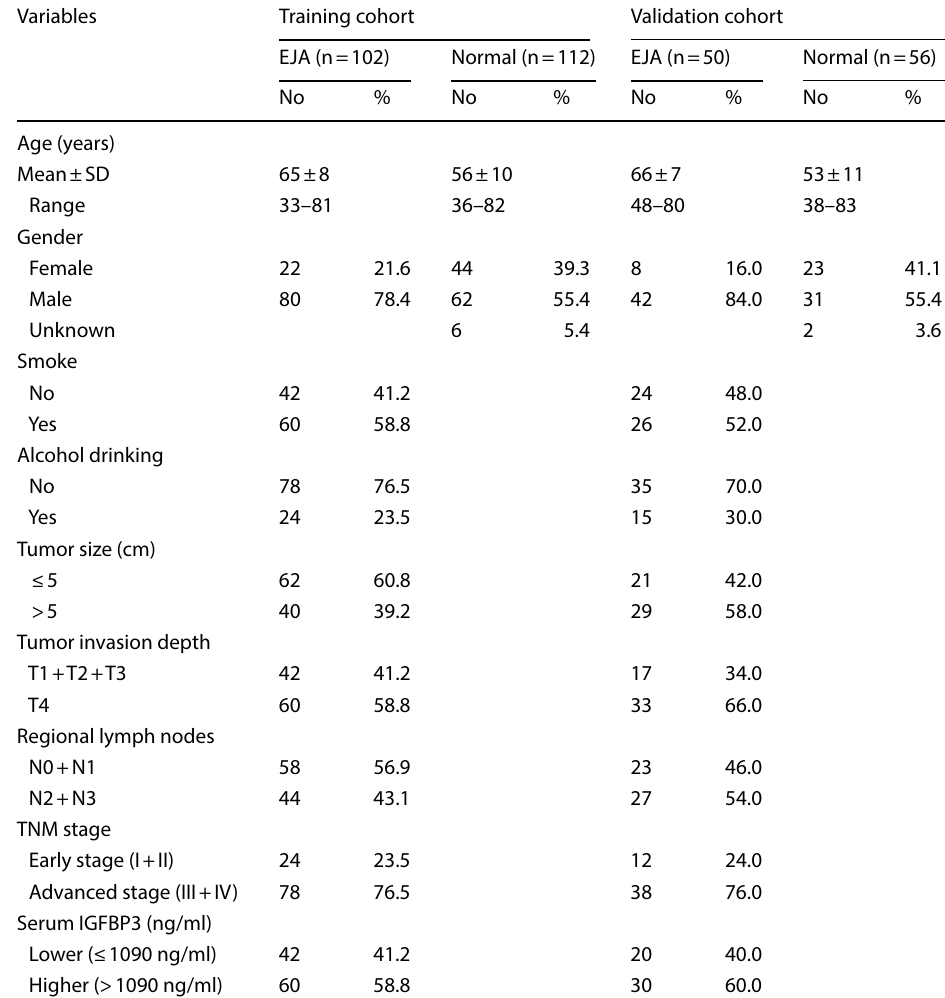
Table 1 Clinical characteristics of samples in two